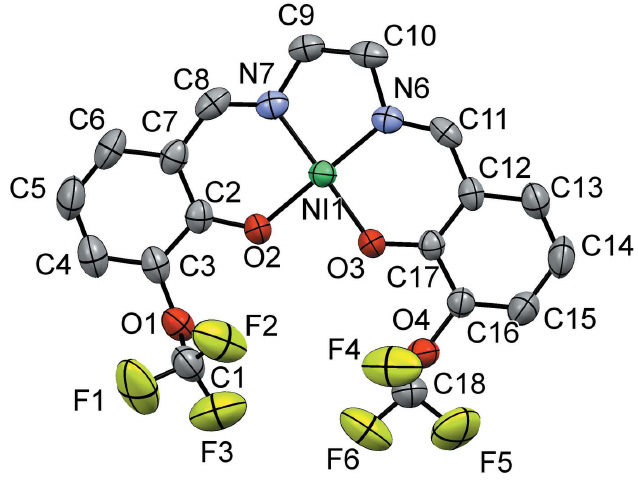
Figure 1 The molecular structure of the asymmetric unit of the title compound with the atom labelling. Displacement ellipsoids are drawn at the 50% probability